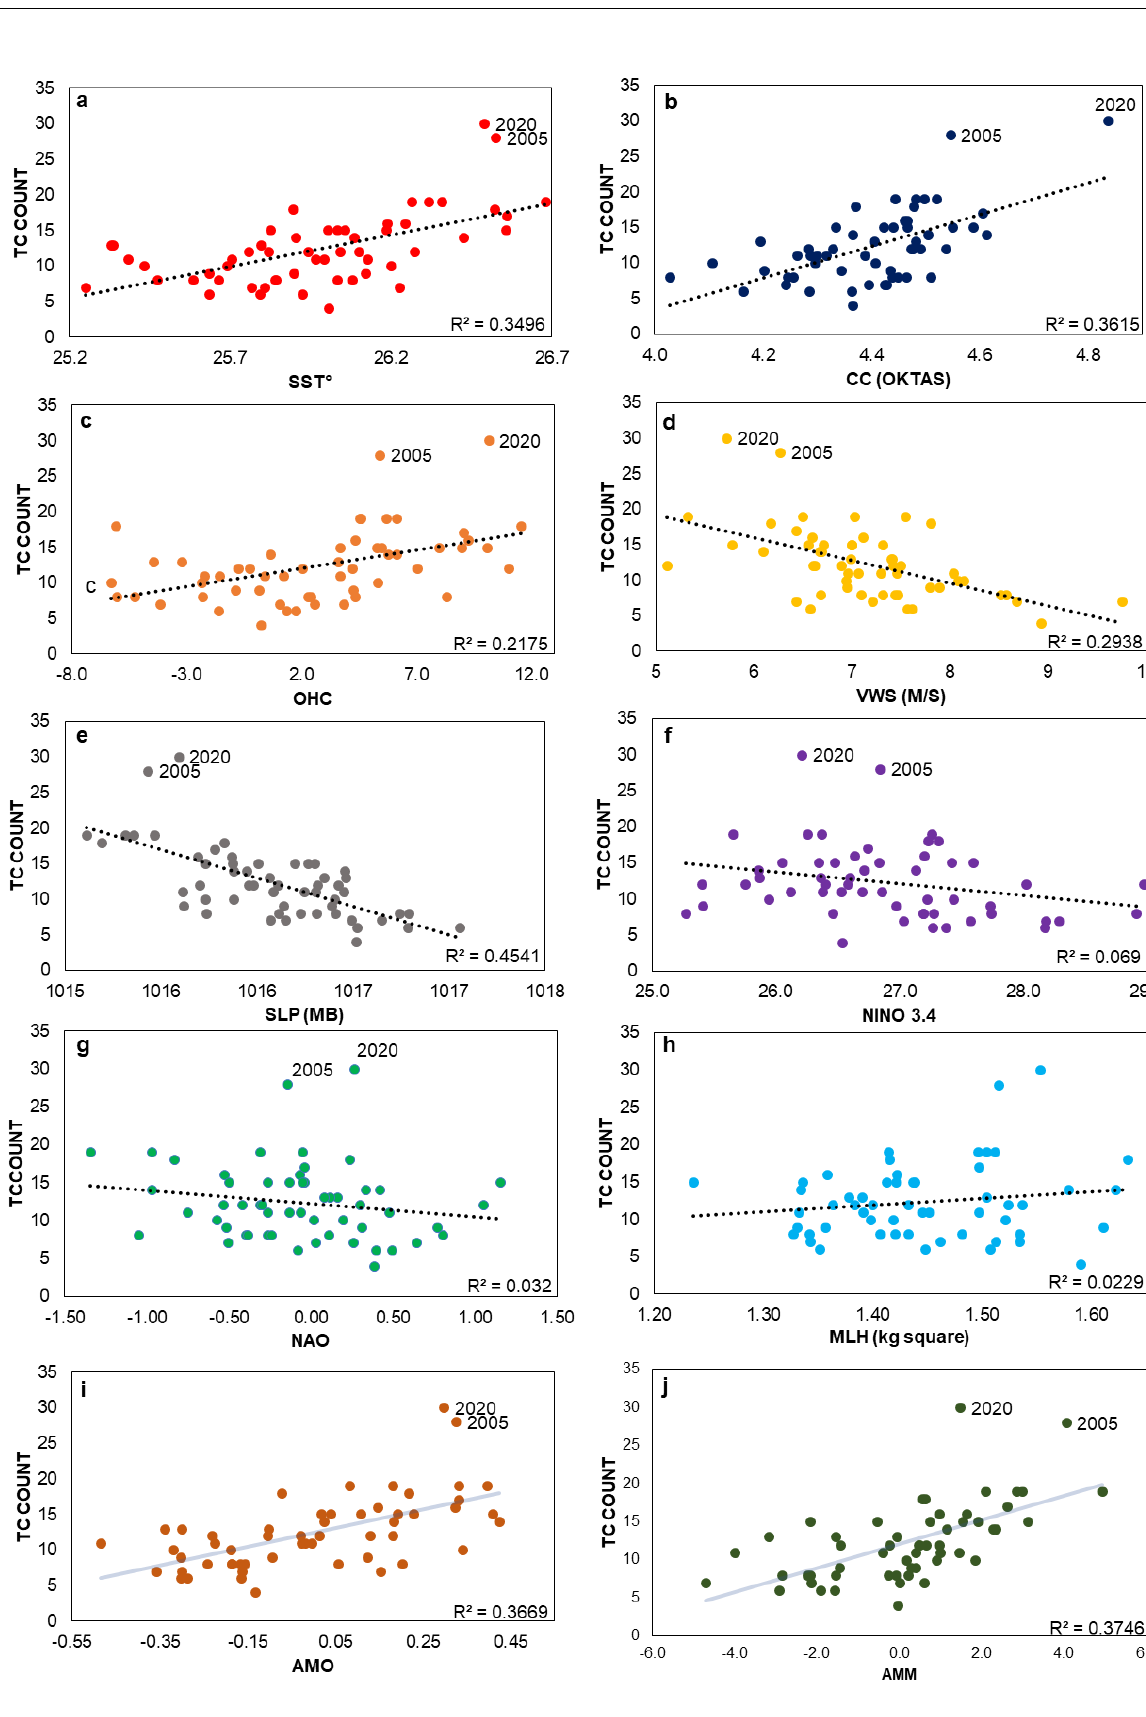
Figure 4. Correlation plots between the total TC count and SST ( a ), CC ( b ), OHC ( c ), VWS ( d ), SLP ( e ), ENSO ( f ), NAO ( g ), MLH (h), AMO ( i ), and AMM ( j ).